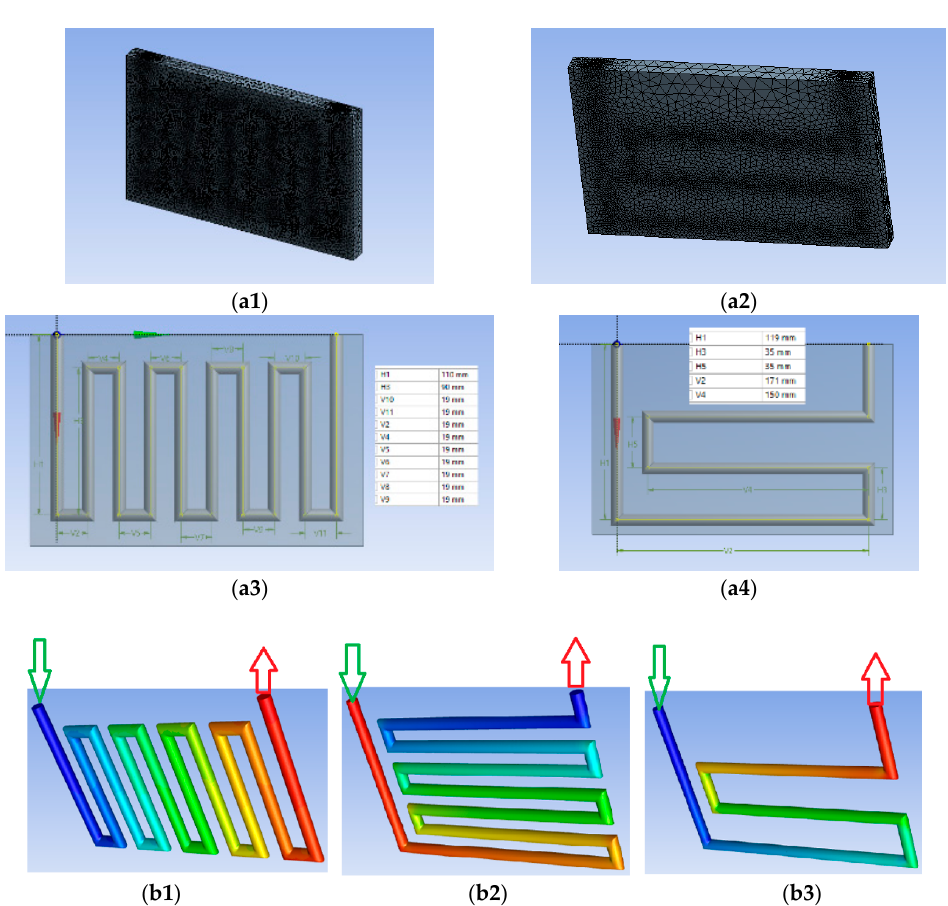
Figure 2. ( a1 ) The mesh model of case A, ( a2 ) the mesh model of case C, ( a3 ) dimensions of cold plate for case A, ( a4 ) dimensions of cold plate for case C, ( b1 ) flow direction of case A ,( b2 ) flow direction of case B ,( b3 ) flow direction of case C.